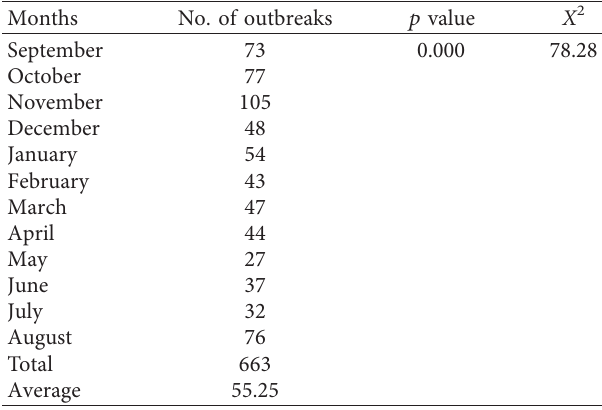
Table 3: Monthly distribution of SGP disease in Eastern Amhara region from September 2013 to December